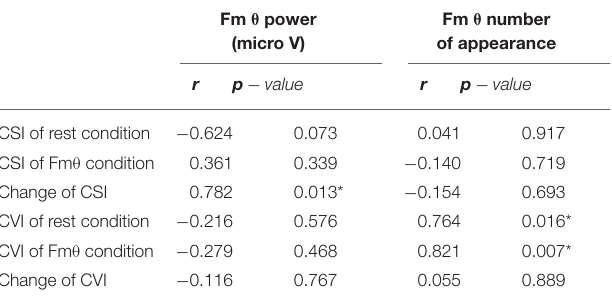
length of the longitudinal (L) and transverse (T) axes within